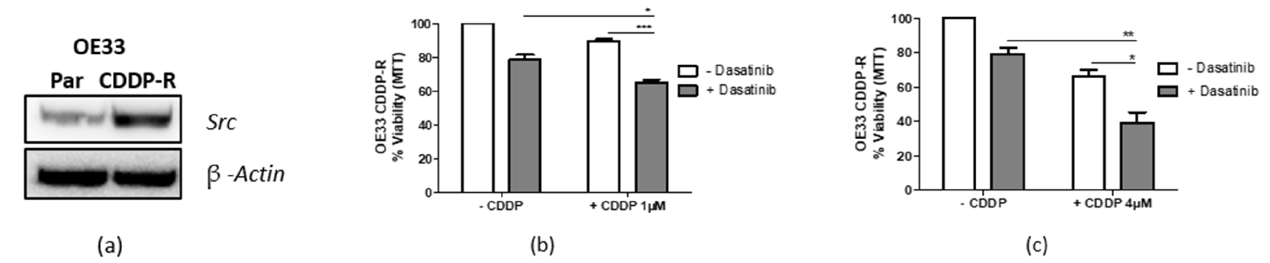
Figure 5. Targeting Src re-sensitizes CDDP-resistant OE33 cells. ( a ) OE33 parental (Par) and OE33 CDDP-resistant (CDDP-R) were assessed for SRC levels by Western blot and β-actin was used as a loading control. ( b ) OE33 CDDP-R cells were treated with dasatinib (~IC 30 (72 h) ) in combination with 1 µ M CDDP (OE33 parental ~IC 30(72 h) ) or ( c ) 4 µ M CDDP (OE33 CDDP-R ~IC 30(72 h) ) for 72 h. Viability was assessed using MTT assays and Student’s t -test was applied to test for significance with * p < 0.05, ** p < 0.01, *** p < 0.001, and ns (non-significant). The results represent the mean of